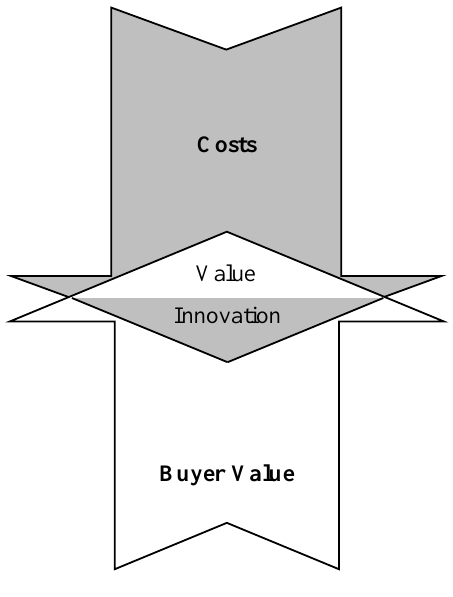
Fig. 1. Value Innovation zone, Source: Adapted from (Kim & Mauborgne,